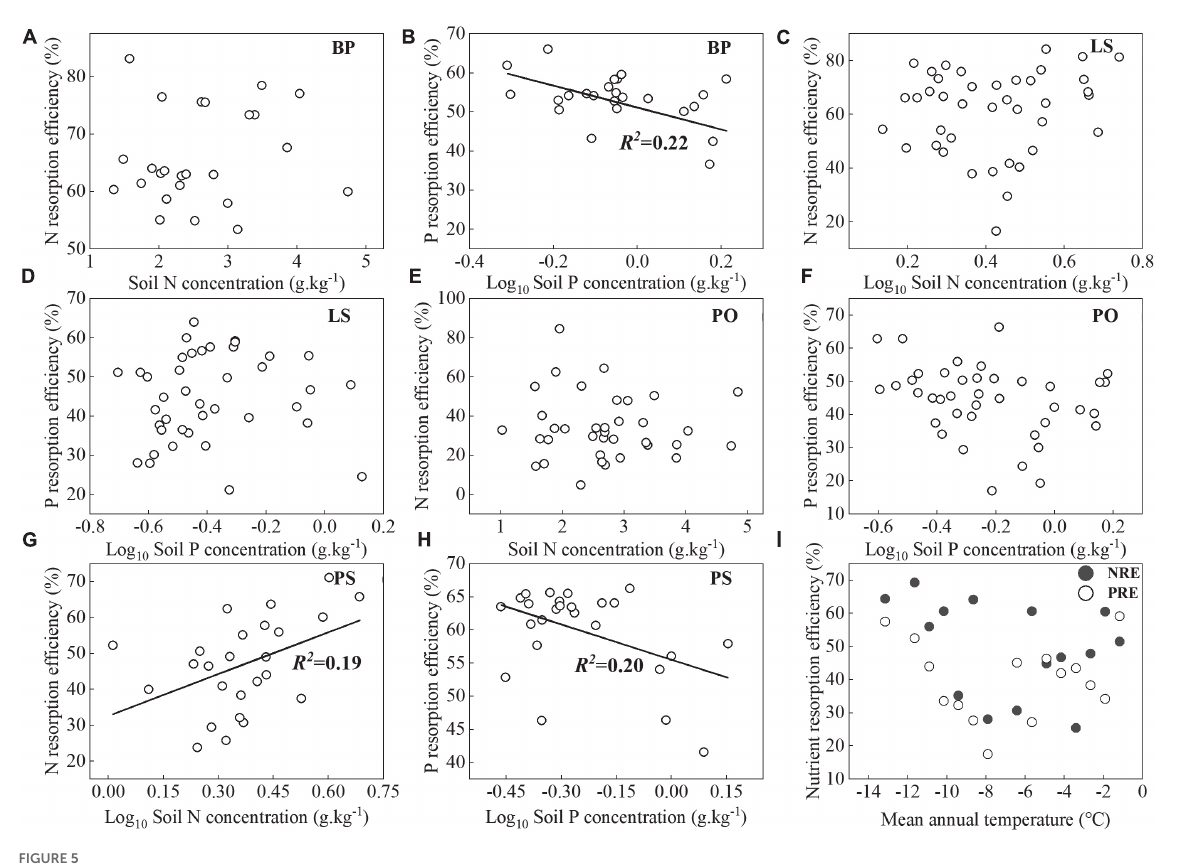
FIGURE5 Relationships between N and P resorption efficiencies and MAT (I) , and soil N and P concentrations (A–H) . Lines were plotted for relationships with p < 0.05.